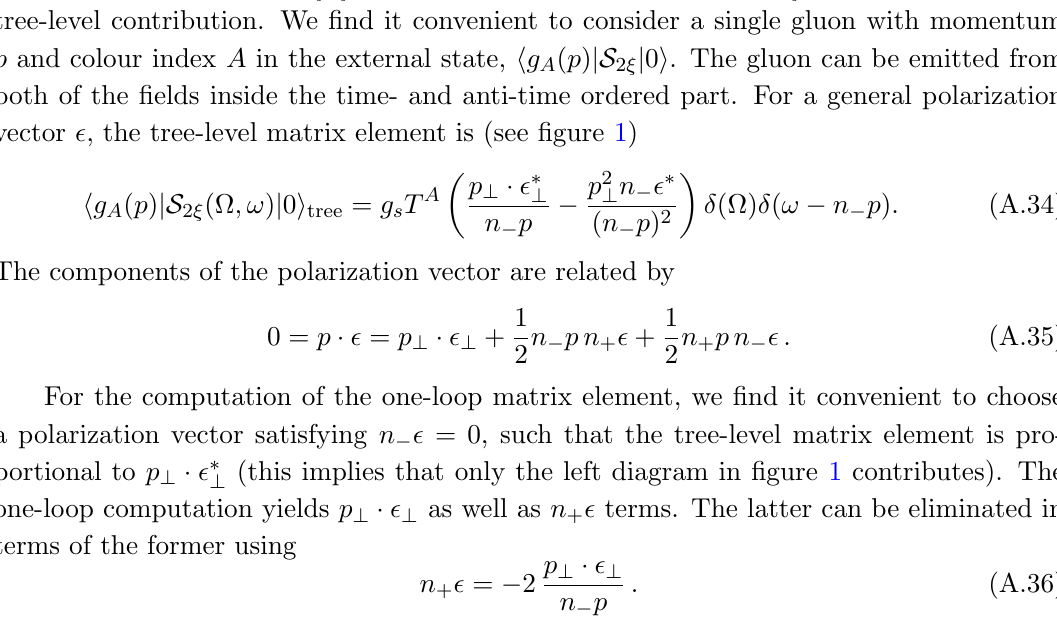
(cid:22) = i@ ? (cid:22) Y y [ iD (cid:22) Y + ], s + + in (cid:0) @ B in (cid:0) @